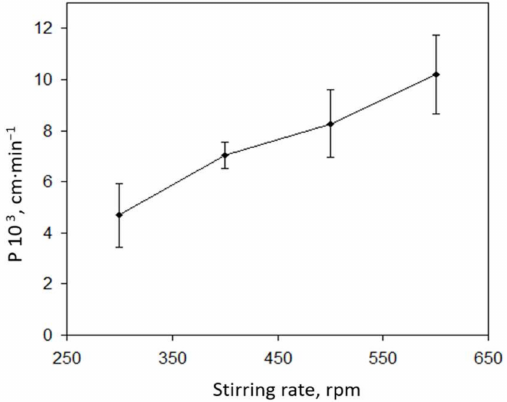
Figure 3. Variation of the permeability coefficient with the stirring rate. Source solution: 1 mg · L − 1